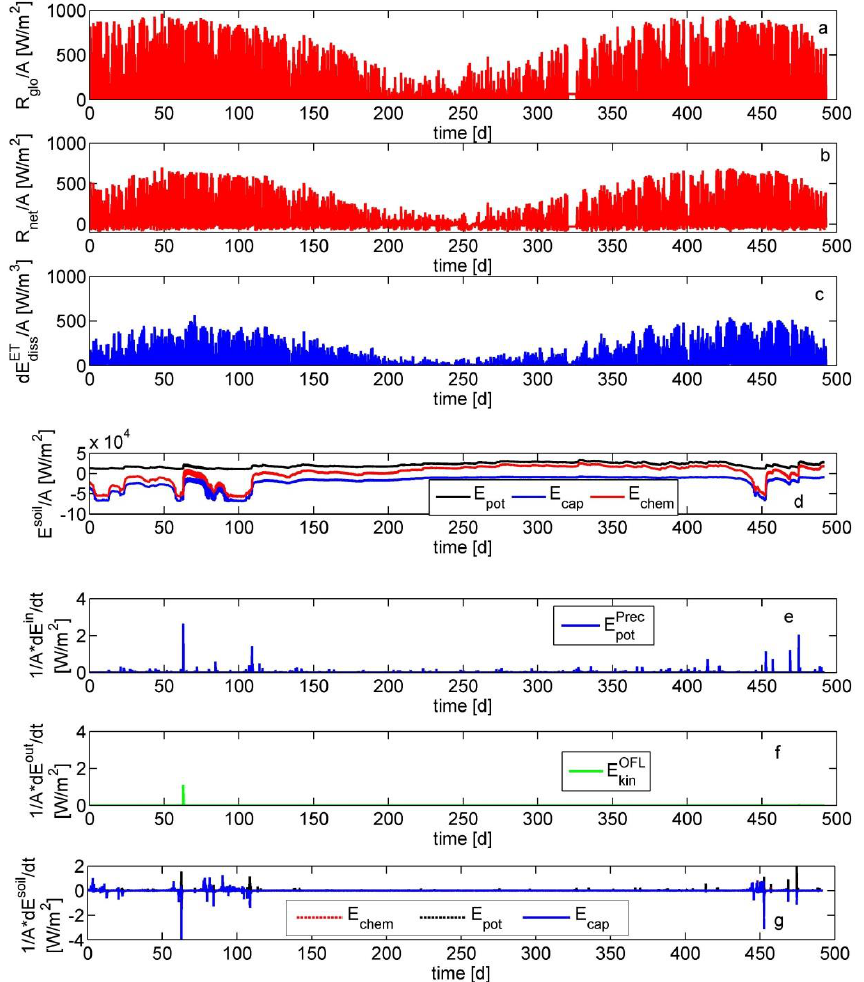
Fig. 8. Free energy balance components as functions of time for numerical experiment 2 in the Weiherbach. Observed global radiation input (a) , simulated radiation balance (b) and simulated latent heat flux λ ET (c) as function of time, trajectories of capillary binding energy, potential energy and total free energy of soil water (d) (derived from Eq. 2, the curves in (g) are the numerical derivatives of the curves in (d) with respect to time). Potential energy input by rainfall (e) , kinetic energy export by surface runoff and potential energy loss by means of groundwater recharge (f) , as well as temporal changes in free energy, capillary binding energy and potential energy of soil water (g) (compare Eqs. 7 or